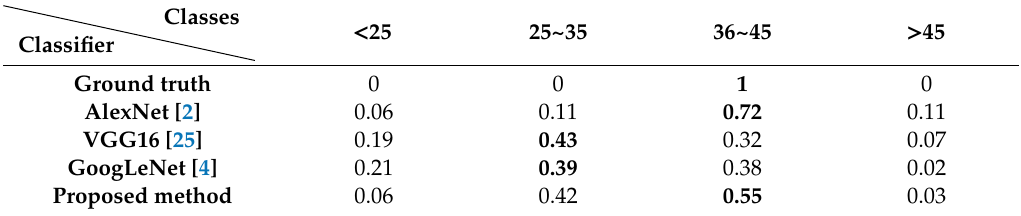
Table 18. Recognition results of the CACD2000 photo.